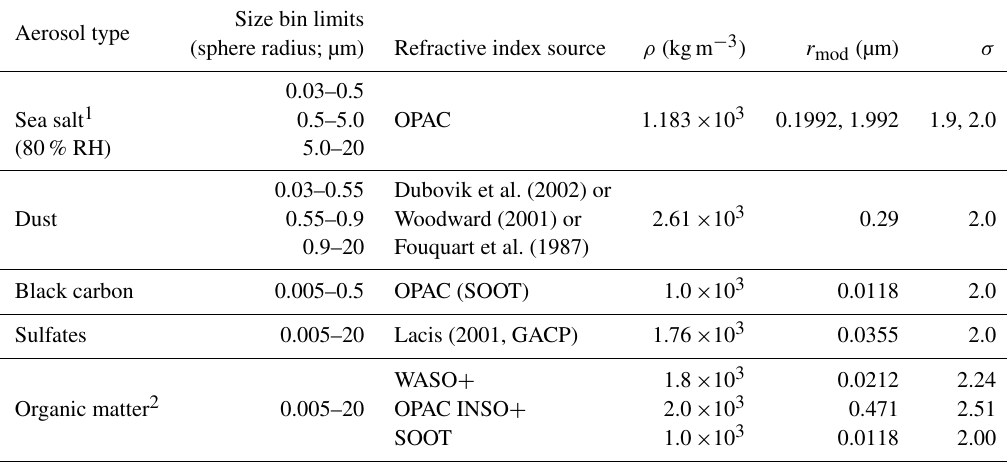
Table A1. Refractive index and parameters of the size distribution associated with each aerosol type in the CAMS model ( r mod = mode radius, ρ = particle density and σ = geometric standard deviation). Values are for the dry aerosol apart from sea salt, which is given at 80%RH. The organic matter type is represented by a mixture of three OPAC types that are similar to the average continental mixture, as described in Hess et al.